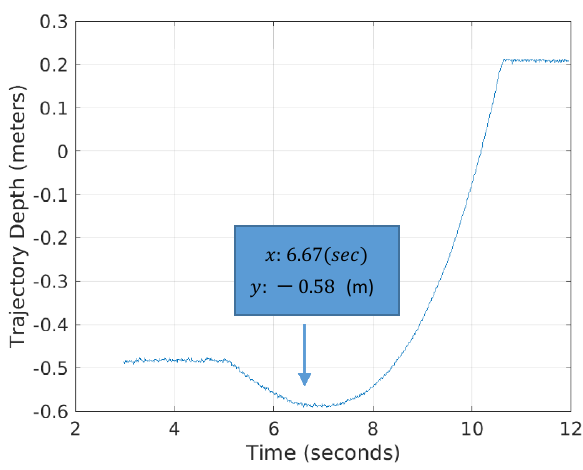
Figure 26. Bucket trajectory with respect to time during the excavation cycle at the 6th segment (Natural Ground 3).